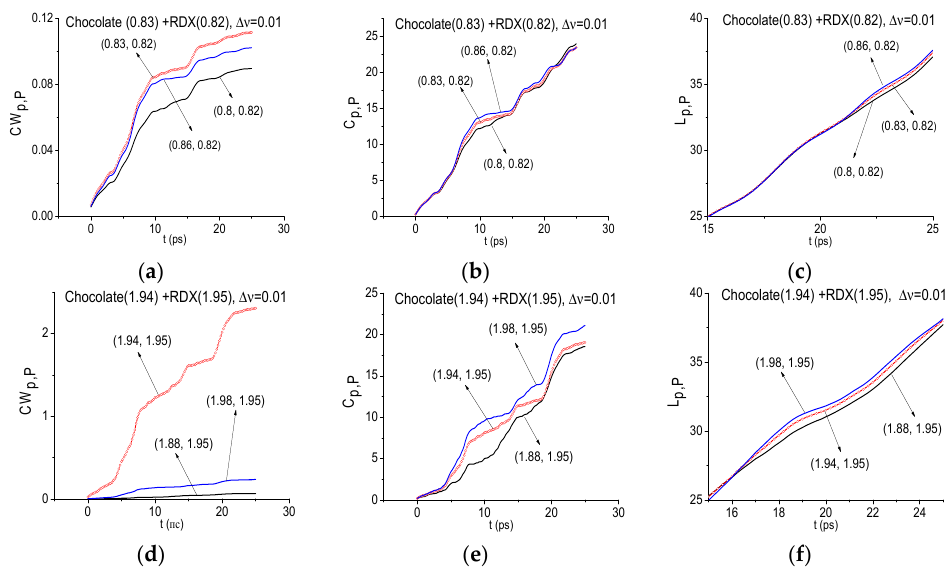
Figure 12. ICC’s CW p,P ( a , d ) C p,P ( b , e ) and L p,P ( c , f ), calculated for frequencies ν = 0.83 THz ( a – c ), 1.94 THz ( d – f ) with the spectral resolution Δ ν = 0.01 THz for signal Chocolate and the standard RDX_Air signal.